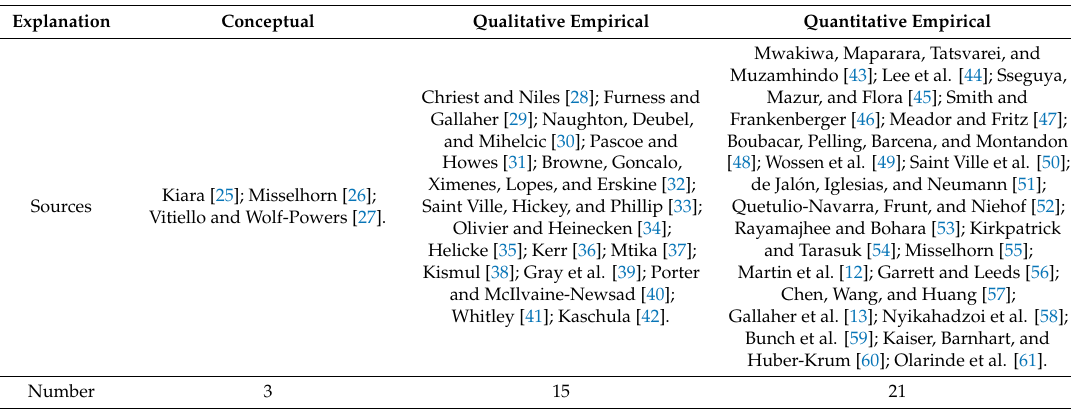
Table 1. Documents based on research type.